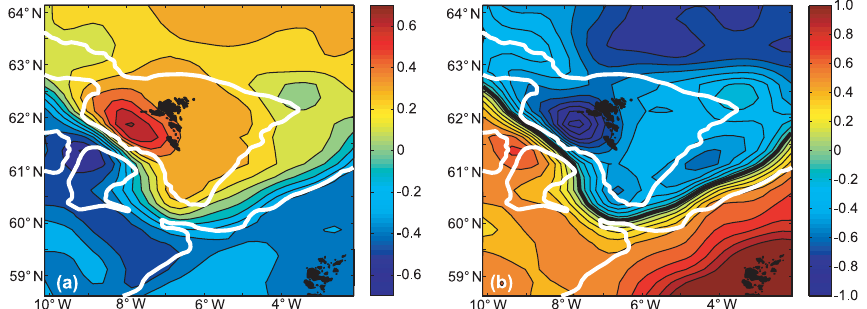
Figure 9. Relationships between Atlantic water transport through the Faroe Bank Channel and altimetry values in the region. (a) Correlation coefficient between (cid:49) SLA FBC and SLA* in all grid points of the region. (b) Negative value of the regression coefficient (slope) of SLA* in all grid points regressed on (cid:49) SLA FBC , where the zero value is indicated by a thick black line. The thick white lines indicate the 500m bottom contour. Based on weekly averages.